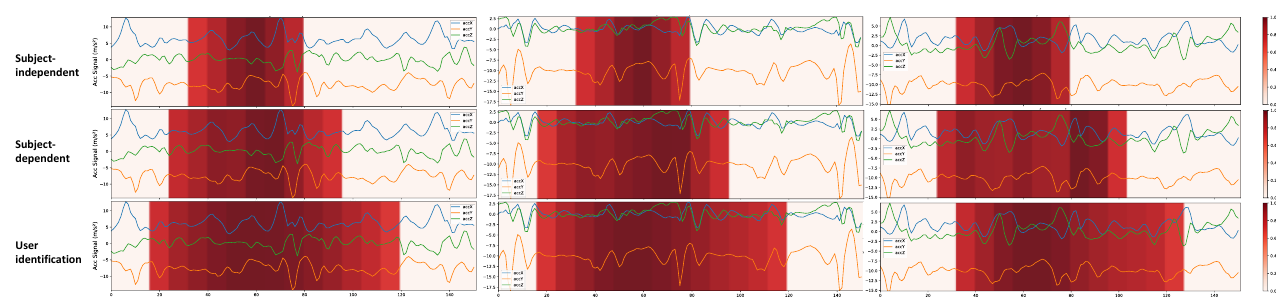
Figure 13. Higher-importance segments for decision making in the CNN1 architecture, for HAR with SI, HAR with SD, and user identification, considering Walking samples with different subjects. The darker the area, the more critical it is for decision making. To obtain these heatmaps, a threshold of 0.7 was considered in the grad-CAM result in order to make more evident the regions of greater importance.